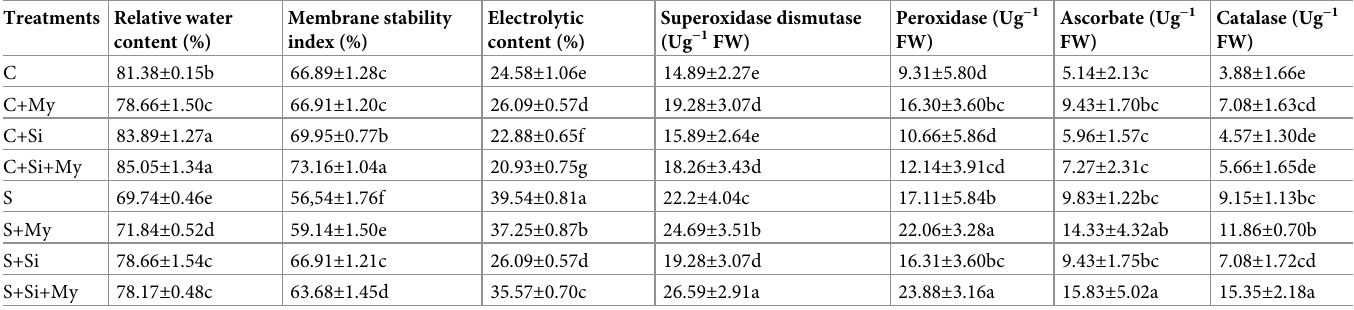
Table 2. Variation among the different treatments for different stress tolerance indicator traits of Brassica juncea when treated with silicon along with mycorrhizal inoculation of under water stress in the influence of silicon and mycorrhizal inoculation. Treatments Relative water content